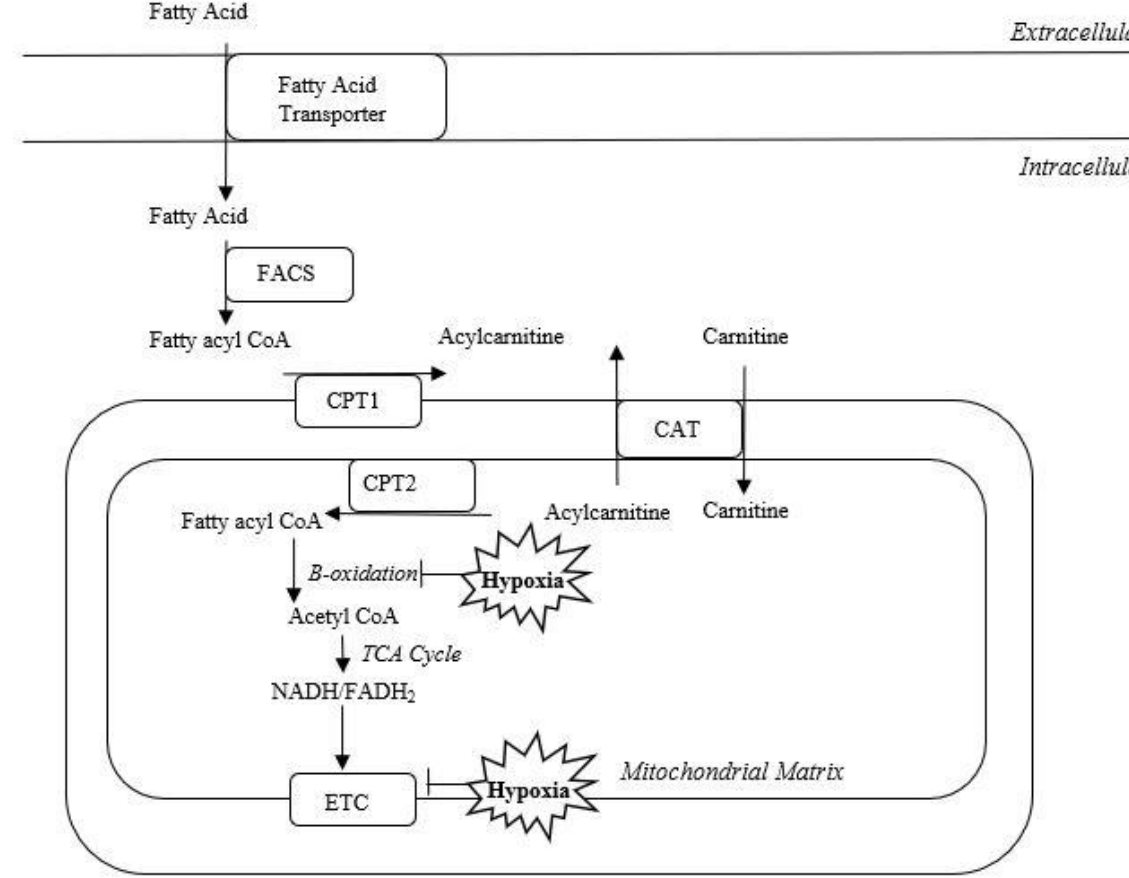
Figure 4. Cell hypoxia results in the inhibition of oxidative phosphorylation and beta-oxidation in the mitochondria, leading to the accumulation of fatty acids and acylcarnitines. Fatty-acyl-CoA synthase (FACS); carnitine palmitoyltransferase 1 (CPT1); carnitine palmitoyltransferase 2 (CPT2), carnitine acetyltransferase (CAT); electron transport chain (ETC).